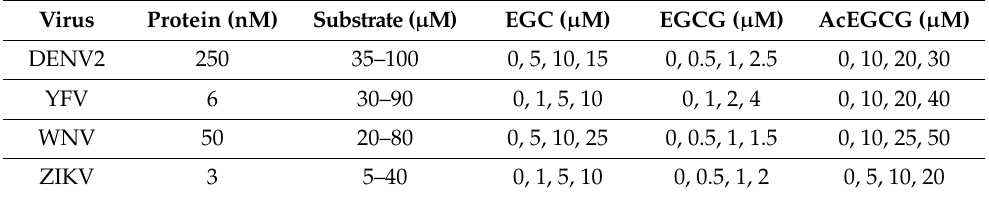
Table 2. Protein, substrate, and epigallocatechin molecules concentration used in the inhibition mode assay.